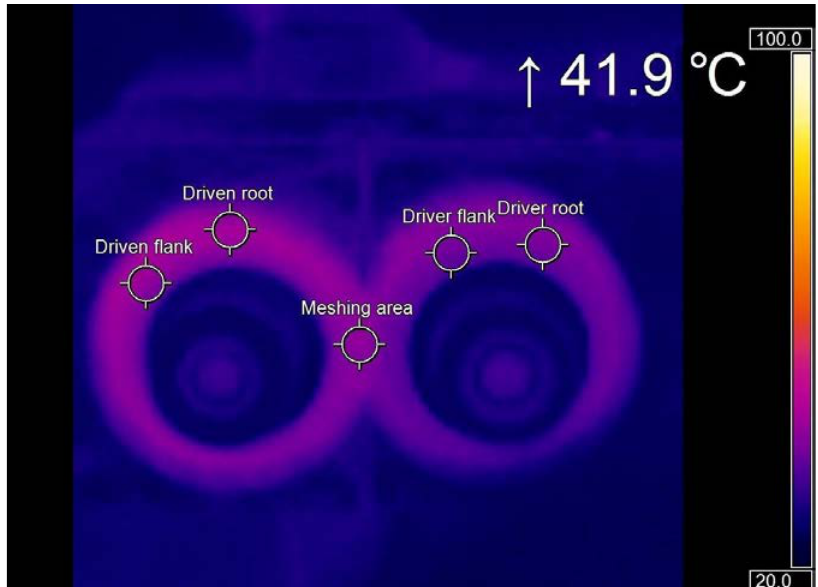
Figure 5. Thermal image of operated gear pair with temperature of meshing area (41.9 °C).